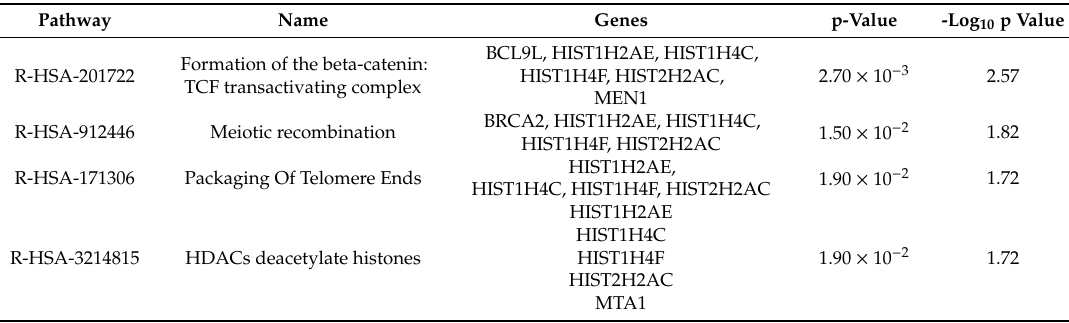
Figure 4. Significantly enriched pathway terms of upregulated differentially expressed genes in placenta tissue of patients with preeclampsia. Differentially expressed genes’ functional and signaling pathway enrichment were conducted using online websites for KEGG PATHWAY, BBID, BIOCARTA and Reactome. Table 4. Signaling pathway enrichment analysis of upregulated differentially expressed genes’ function in placenta tissue of patients with preeclampsia.